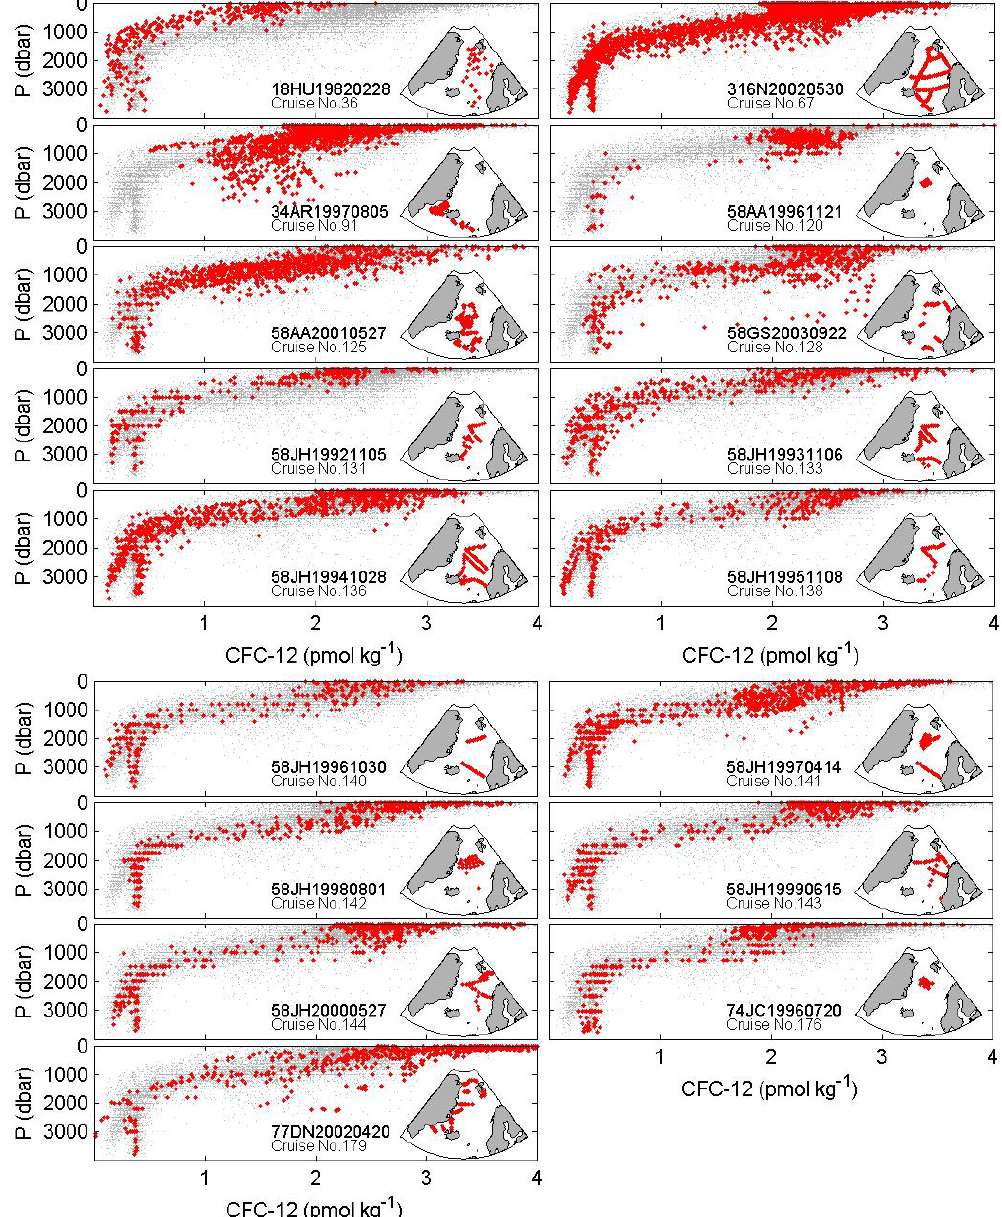
Figure 3. CFC-12 vs. pressure (dbar). See Fig. 2 for